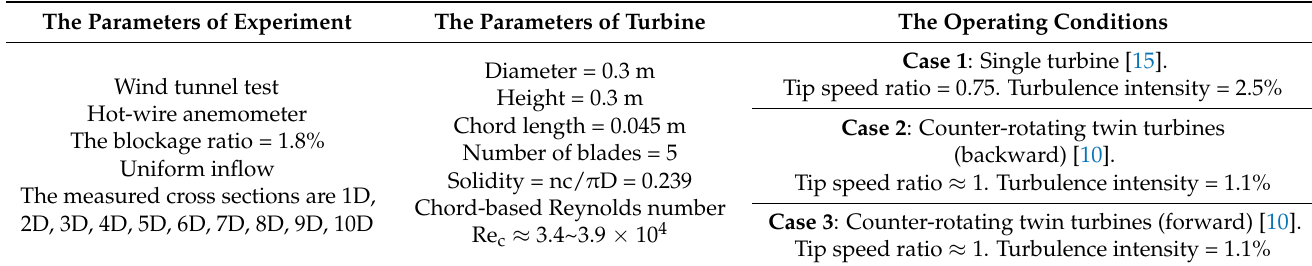
Table 4. The basic information of these three